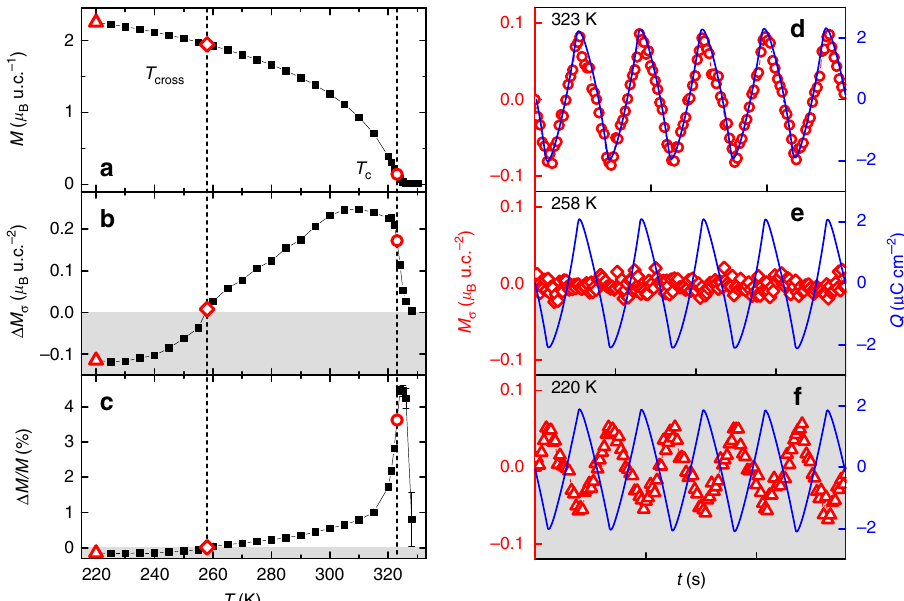
Figure 3 | Temperature-dependence study on constant surface charge modulation D Q E 4 m Ccm (cid:2) 2 . ( a ) Magnetic field-cooled curve performed before in situ tuning revealing a T C E 323K. ( b , c ) Response of the magnetic modulation normalized per LSMO surface unit cell ( b ) and with respect to the volume magnetization ( c ). A crossover temperature T cross E 258K separates in-phase (white area) and anti-phase (grey area) magnetic responses with respect to the surface charge modulation. ( d – f ) Time-resolved magnetic response at T C ( d ), T cross ( e ) and 220K ( f ). Each time step in d – f on the abscissa corresponds to